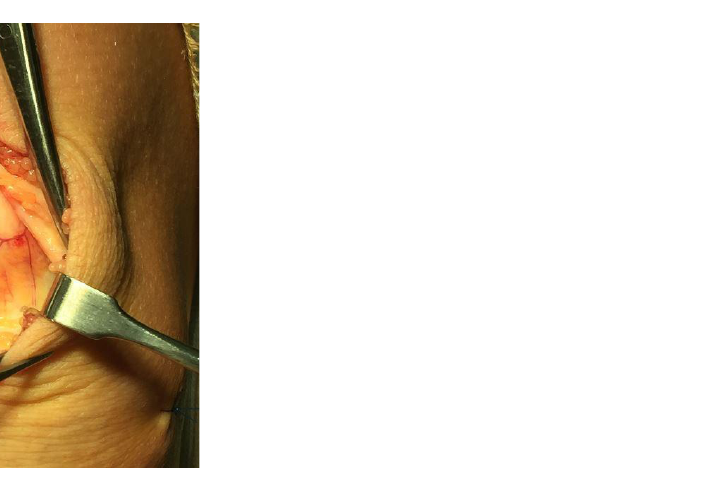
Figure 2. Surgical inspection of the superficial peritendinous tissue. Richly vascularized fatty tissue can be observed.